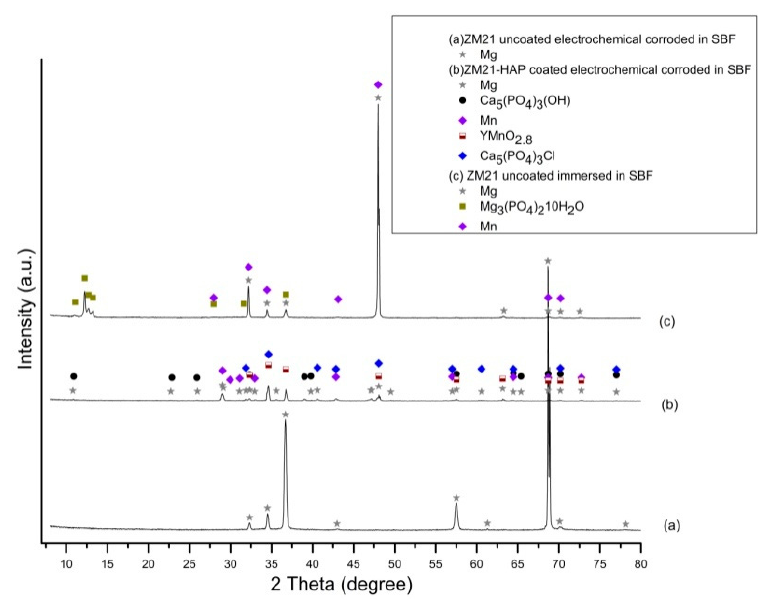
Figure 17. XRD patterns of uncoated ZM21 alloy after electrochemical corrosion ( a ), HAP coated ZM21 alloy after electrochemical corrosion ( b ) and uncoated ZM21 alloy after immersion corrosion in SBF ( c ) (bullets indicate the peaks corresponding to diffraction angles of the main phases).